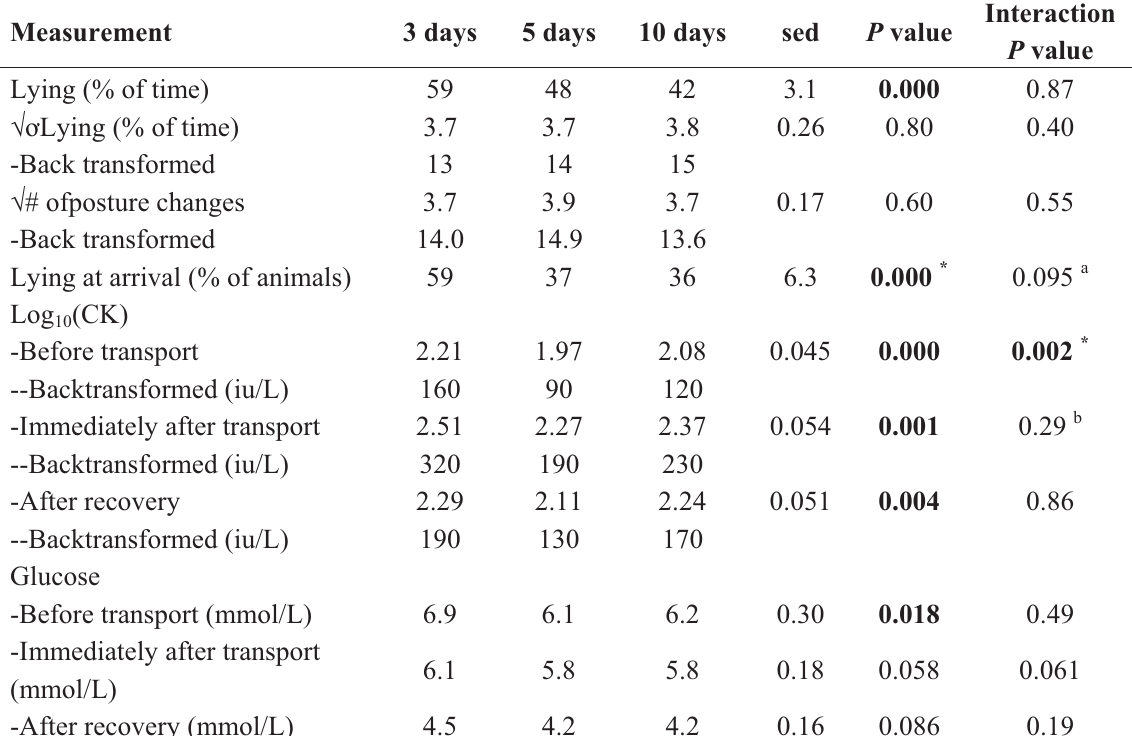
Table 2. Effect of age on behaviour and physiology before, during and after transport, and after 12 h of recovery. The interaction P value is the P value for testing for any interaction between calf age and the space or flooring treatments. Approximate least significant differences can be calculated as the sed multiplied by